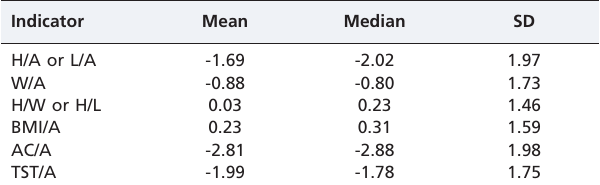
Table 2 - Mean ( ¡ SD) and median of anthropometric indicators (Z) of children and adolescents assessed after liver transplant.